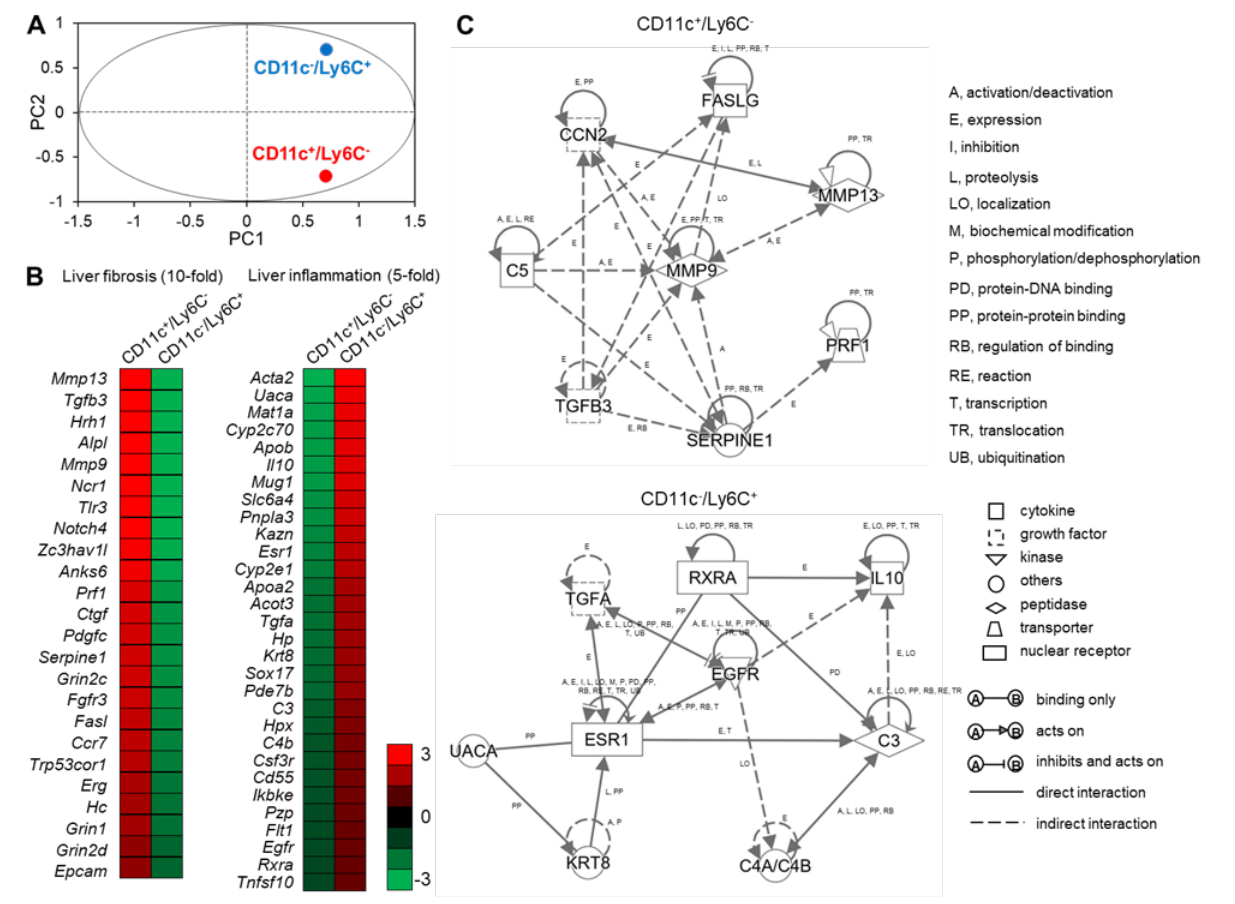
Figure 7. RNA sequence analysis of CD11c + /Ly6C − and CD11c − /Ly6C + cells in the liver from iHFC diet-fed TSNO mice. ( A ) PCA of two subsets of recruited macrophages from TSNO mice fed with the iHFC diet for 8 weeks. PCA was performed using Gene Spring. ( B ) Heatmap showing relative expression levels of upregulated or downregulated genes in two subsets of recruited macrophages from TSNO mice fed with the iHFC diet for 8 weeks. ( C ) The changes of the genes were analyzed using Ingenuity Pathways Analysis tools. The networks were displayed graphically as nodes (genes or proteins) and edges (the biological relationships between the nodes). Nodes and edges are displayed by various shapes and labels that represent the functional class of genes and the nature of the relationship between the nodes, respectively.